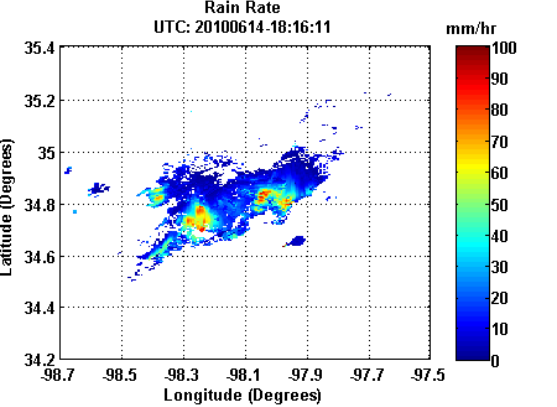
Fig. 7a. Instantaneous rainfall map.